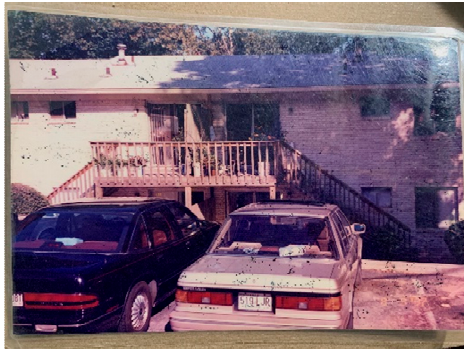
Figure 6. Cars and a new place.